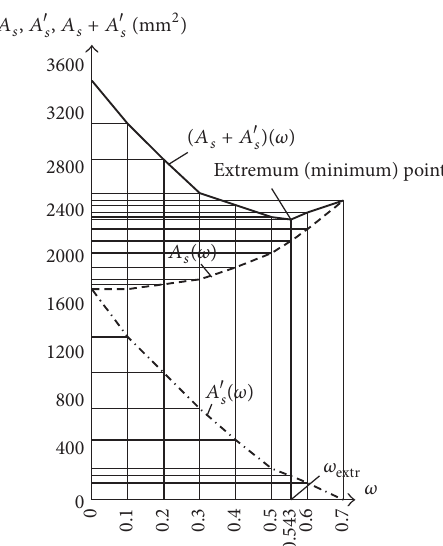
Figure 5: Minimization of total RC section reinforcement ( 𝐴 𝑠 +𝐴 󸀠 𝑠